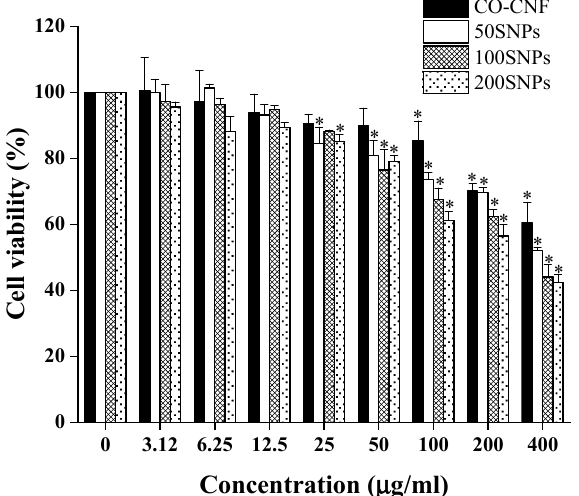
Figure 7. Cell viability of human gingival fibroblast cells (1 × 10 4 cells/well) in the presence of nanoparticles after 24 h. Data are expressed as mean ± S.D. ( n = 3). The asterisk (*) indicated the significant differences of the groups from control at p < 0.05 analyzed by the Tukey test. CO-CNF: κ -carrageenan oligosaccharides linked cellulose nanofibers; 50SNPs: 50 mg surfactin-loaded CO- CNF nanoparticles; 100SNPs: 100 mg surfactin-loaded CO-CNF nanoparticles; 200SNPs: 200 mg surfactin-loaded CO-CNF nanoparticles.